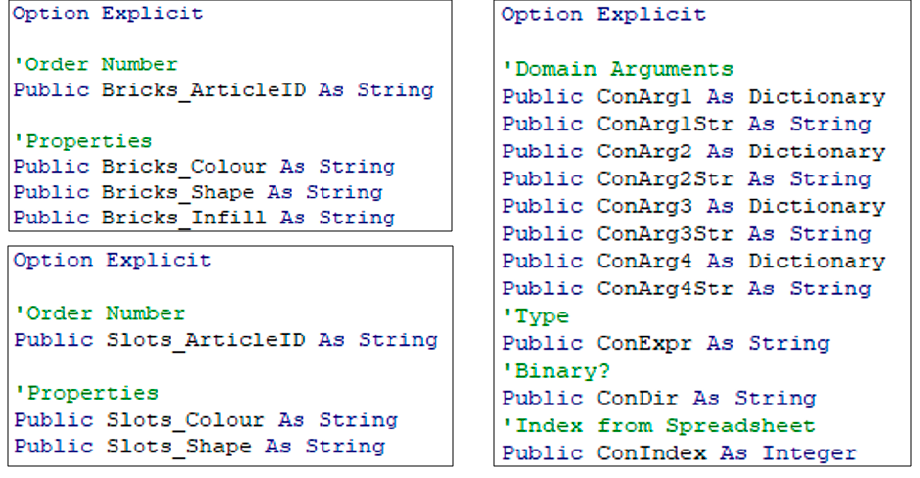
Figure 8. Declaration of public